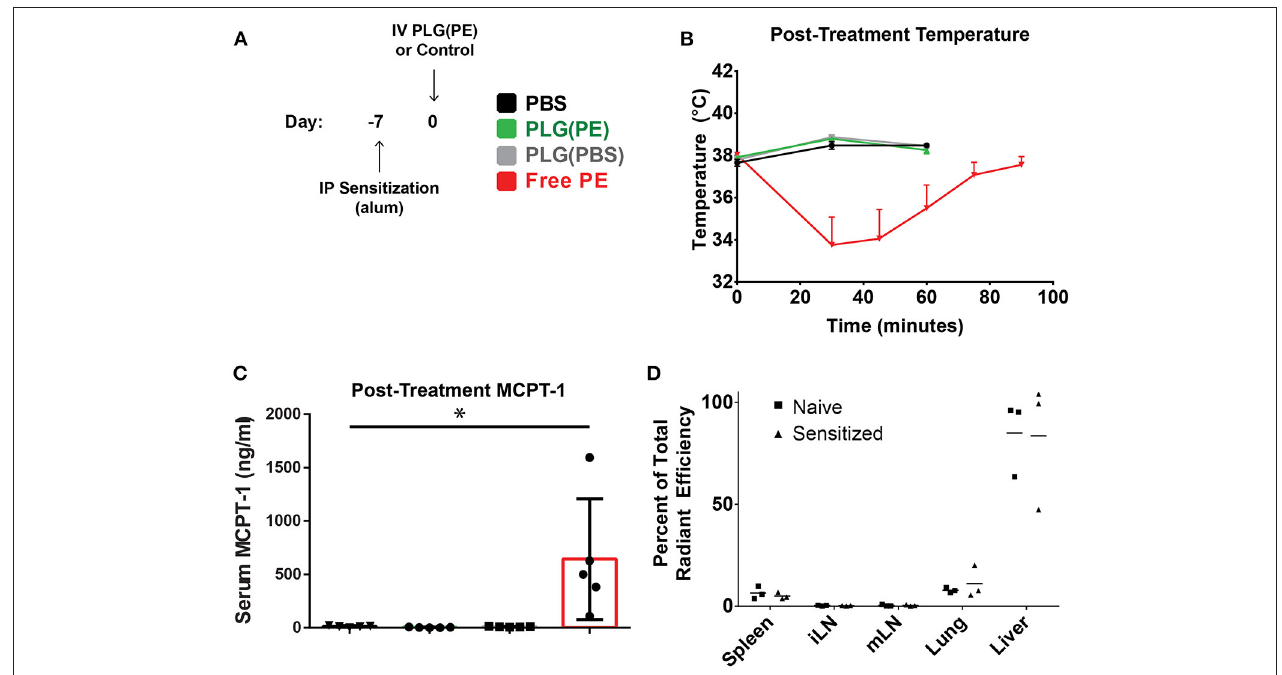
FIGURE 3 | PLG(PE) is well-tolerized in pre-sensitized mice. C3H/HeJ mice received i.p. injection of alum and peanut extract on Day − 7 relative to NP injection (A) . Mice were treated on Day 0 with PLG(PE) NPs or controls and assessed for anaphylactic response to therapy. Intravenous injection of PLG(PE), PBS, or PLG(PBS) were well-tolerated, while injection of an equivalent total dose (25.75 µ g) of soluble peanut extract resulted in anaphylactic temperature drop (B) and serum release of MCPT-1 (B) ( n = 5). (C) Cyanine5.5-labeled, peanut extract-loaded NPs [PLG(PE, Cy5.5)] were injected intravenously. Twenty four hours post-injection, spleens, inguinal lymph nodes, mesenteric lymph nodes, lungs, and livers were collected and imaged by IVIS to determine relative organ distribution in naïve and pre-sensitized mice, presented as percent of total radiant efficiency (D) . Plots display mean measurement ± SEM Statistical Significance: 1-way ANOVA with Tukey’s multiple comparisons test: * P <